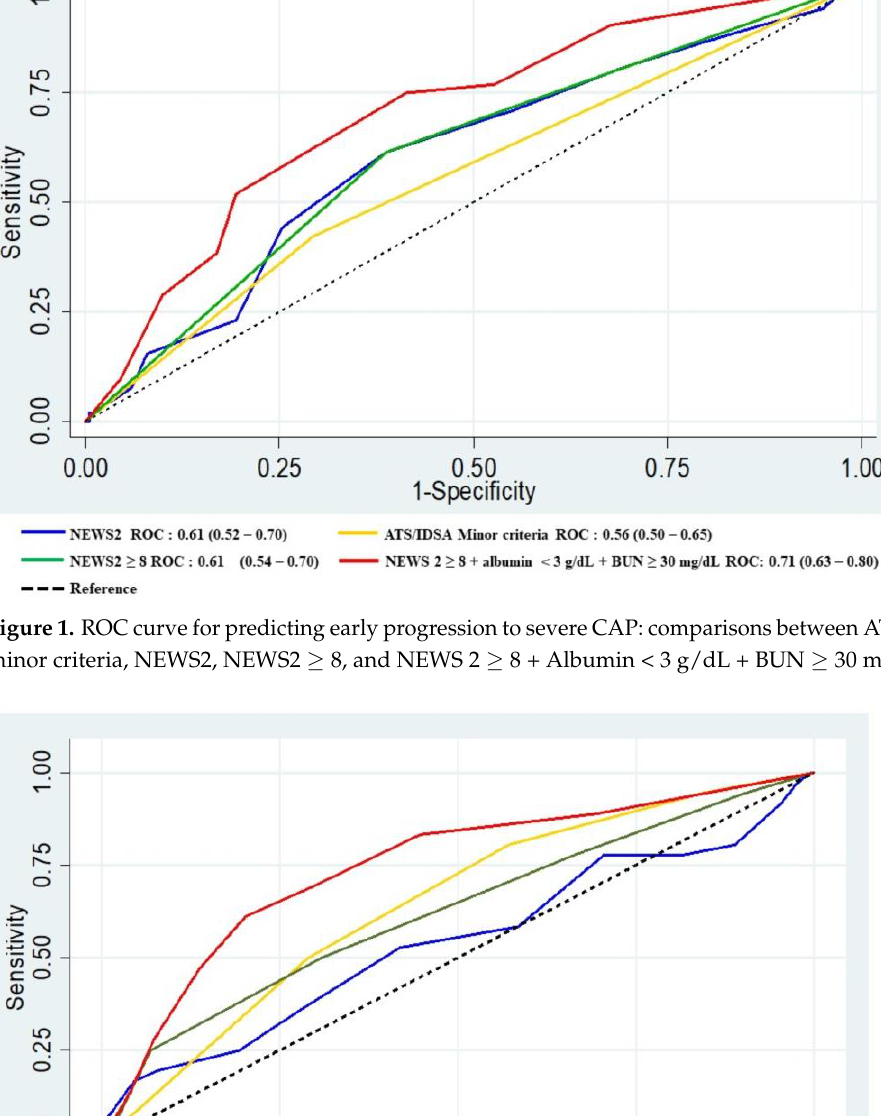
Table 4. AUROC of NEWS2 when compared with IDSA/ATS minor criteria and other prediction tools to predict early progression of pneumonia.